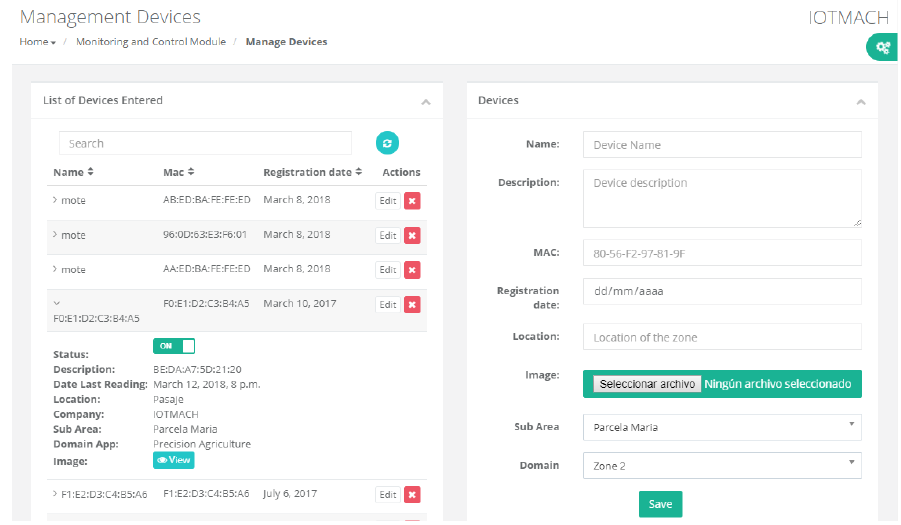
Figure 21. Discovered devices.